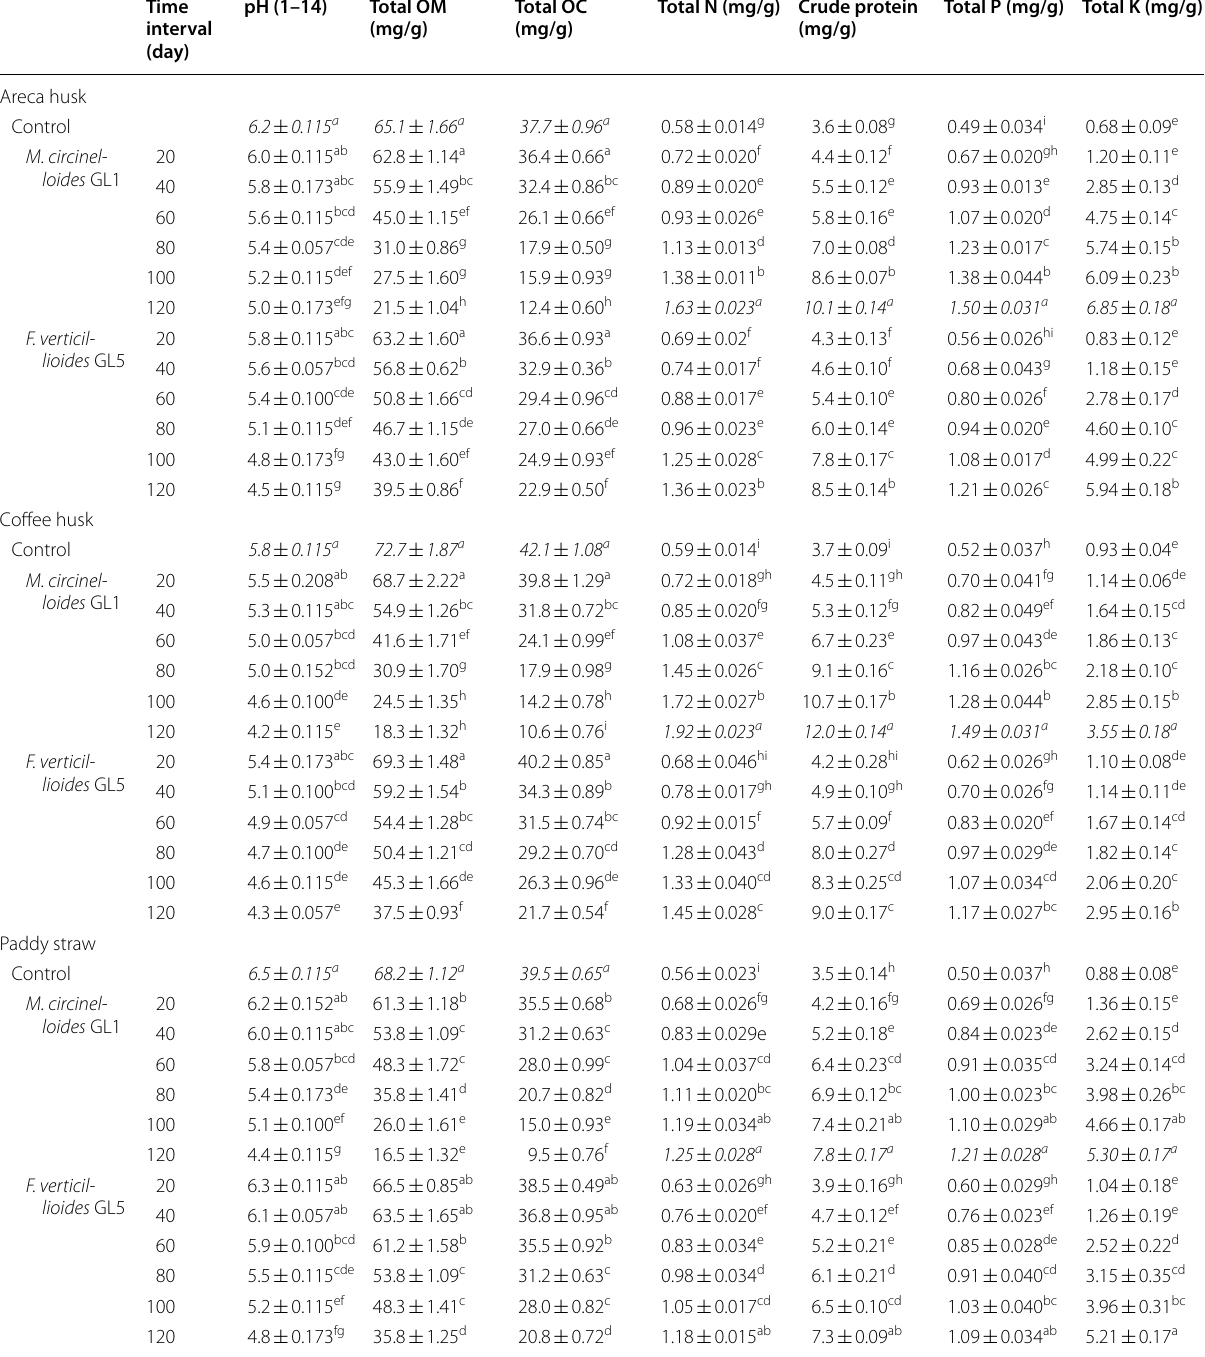
‘ ’ indicates standard error (SE) calculated by using triplicates ± Values (mean of triplicates) with different letters within the same vertical column indicate the significant difference at p A italicized cell represents the maximum value Total OM total organic matter, Total OC total organic carbon, Total N total nitrogen, Total P total phosphorus, Total K total